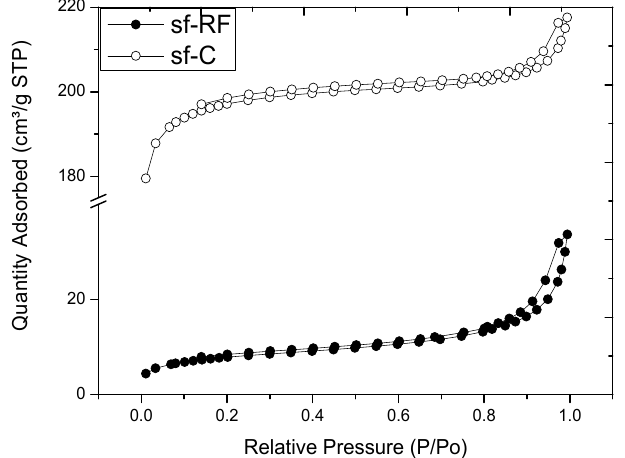
Figure 8. Adsorption and desorption isotherms of sf-RF and sf-C aerogels.